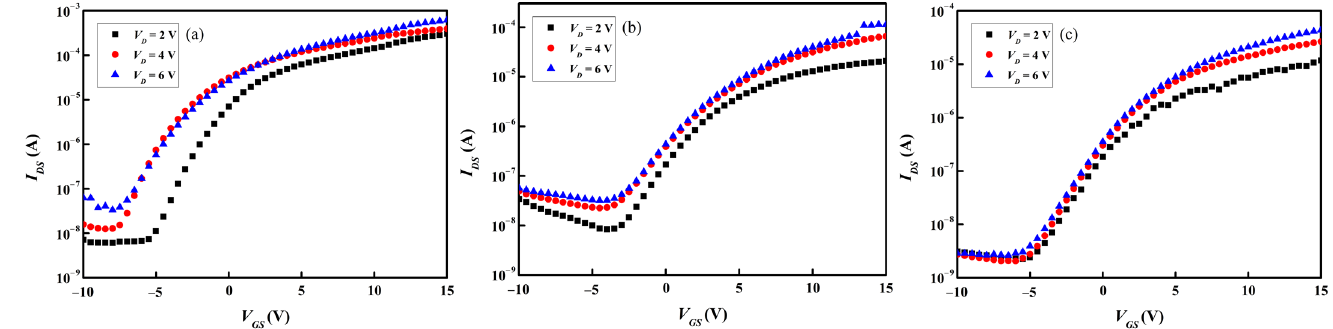
Figure 12. Output characteristics of TFT samples containing ( a ) a -InGaZn 2 O 5 , ( b ) a -InGaZnO 4 , and ( c ) a -InGa 2 ZnO 5.5 active channel layers subjected to the gate dielectric annealing at 300 °C for 1 h in an ambient atmosphere. Table 5. Transfer characteristics of the three types of a -IGZO TFT samples subjected to the gate dielectric annealing at 300 °C for 1 h in an ambient atmosphere.